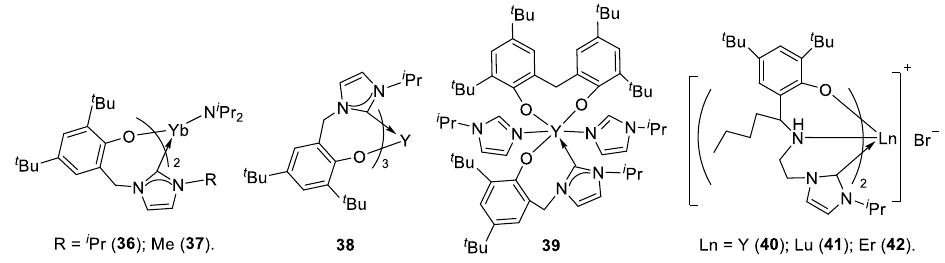
Figure 11. Ln complexes bearing alkoxy-NHC ligands.